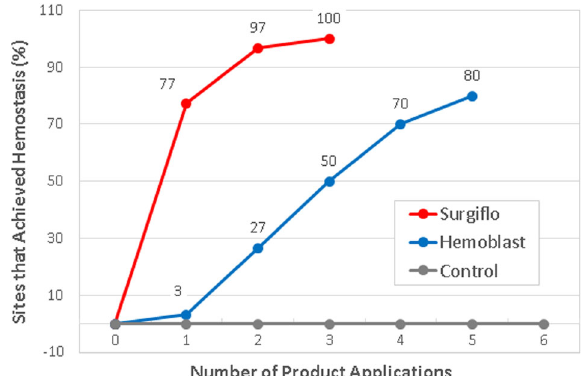
Fig. 5 Cumulative percentage of sites that achieved hemostasis after 1 – 5 product applications. Twenty-four Surgi fl o-treated sites (24/30, 77.4%) achieved hemostasis following 1 application, whereas only 1 (1/30, 3.3%) Hemoblast-treated sites achieved the hemostasis follow- ing a single product application. After 3 consecutive applications, 100% of Surgi fl o-treated sites were hemostatic compared to 50% of Hemoblast-treated sites. 30% and 20% of splenic sites treated with Hemoblast did not achieve hemostasis after 4 and 5 applications, respectively. All Control sites failed as they were not hemostatic after the 5-min observation period and up to 6 tamponade applications. Bleeding of Control sites was stopped by applying another adjunctive topical hemostat (SURGICEL ® SNoW ™ Absorbable